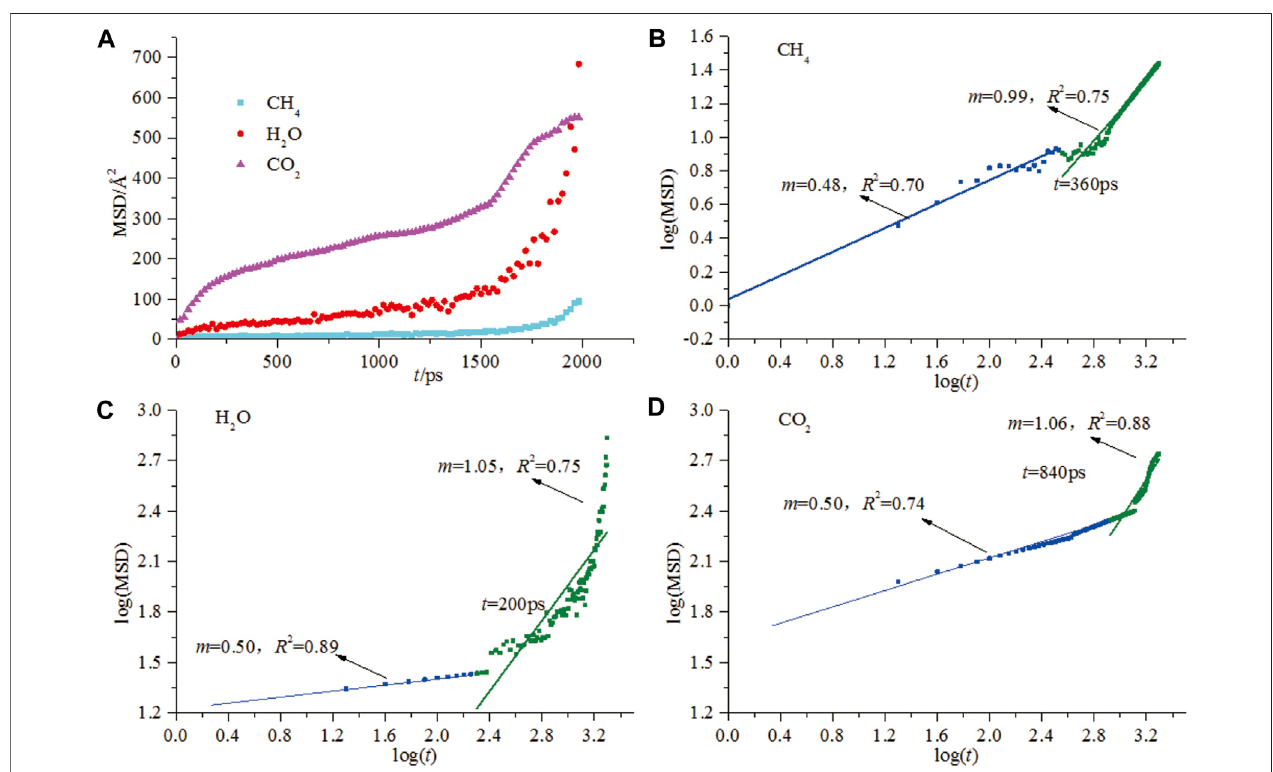
FIGURE 7 | MSD vs. time plot of CH 4 , CO 2 , and H 2 O diffusion (A) and logarithmic plot of CH 4 (B) , CO 2 (C) , and H 2 O, (D) MSD vs. t (from Song et al., 2017b).